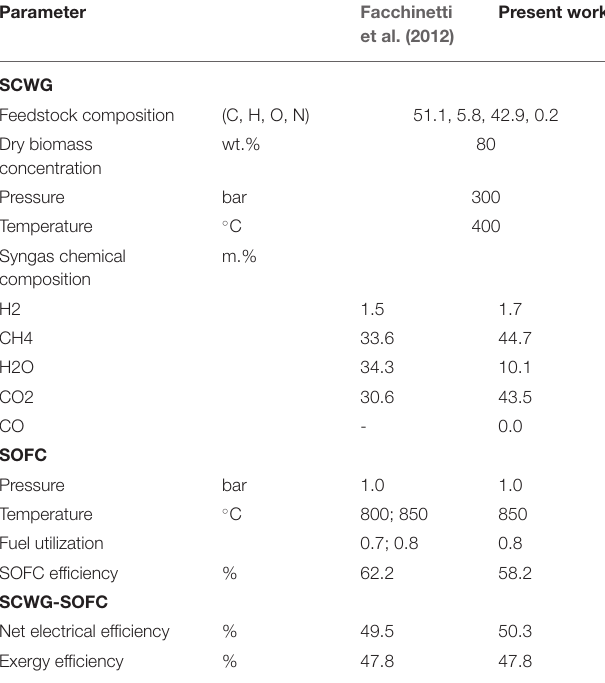
TABLE 2 | Comparison of the simulation results of the supercritical water gasification (SCWG)-solid oxide fuel cell (SOFC) system with the data obtained from reference.